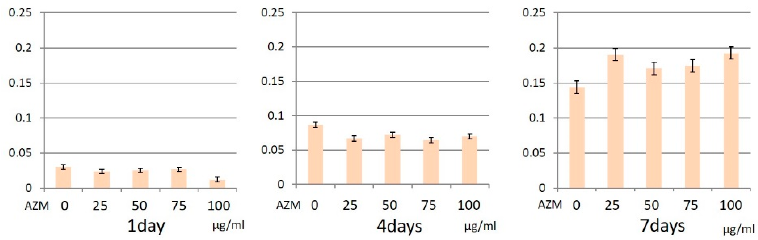
Figure 3. Cell proliferation ability of human gingival fibroblasts (hGFs) with azithromycin (AZM). These experiments were performed in triplicate, and data are presented as the mean ± SD.